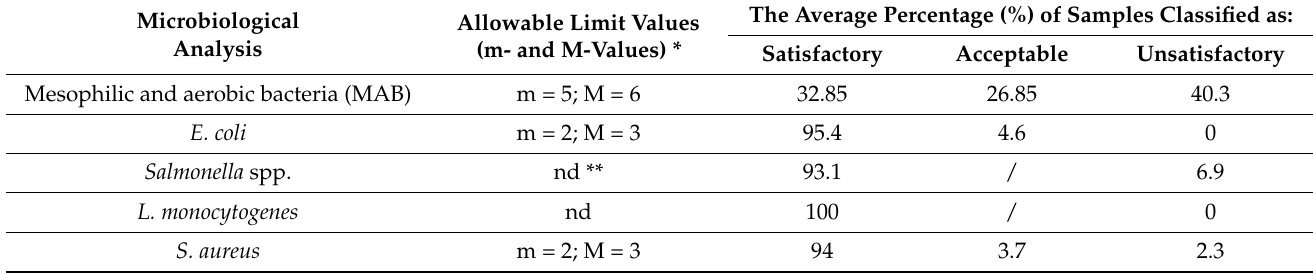
Table 2. The descriptive analysis of minced meat samples.